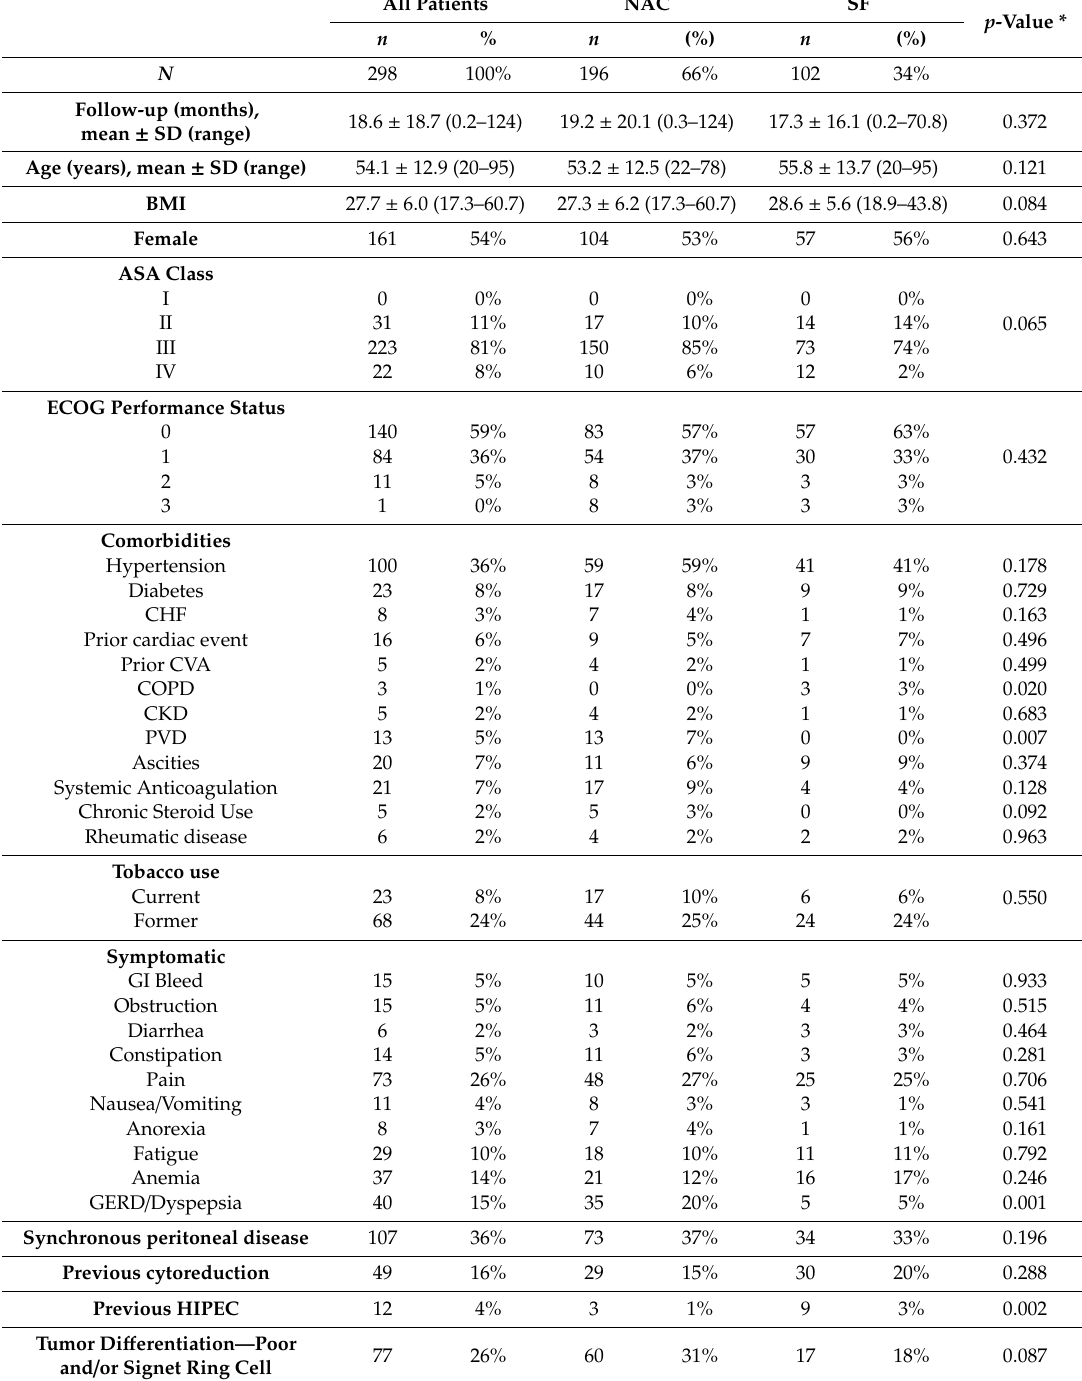
Table 1. Patient Characteristics ( N =